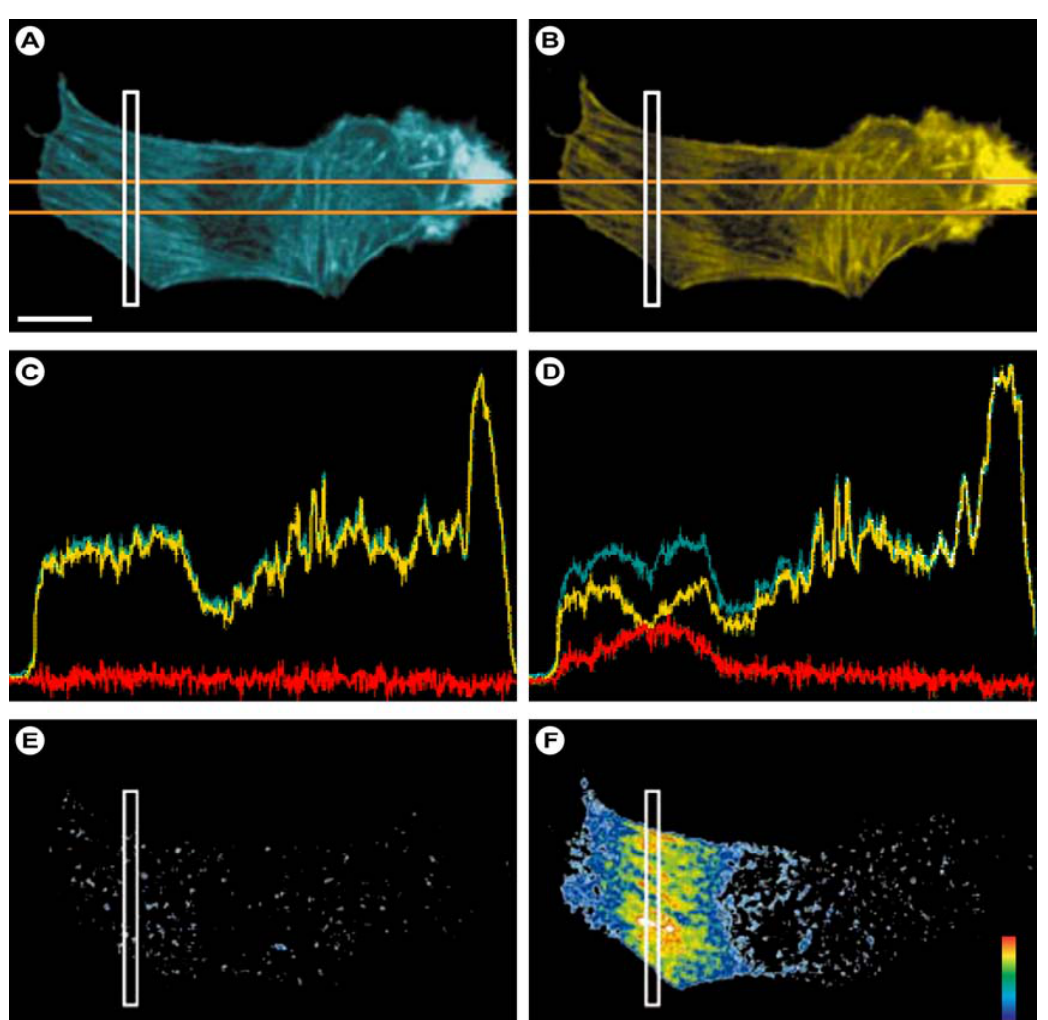
( B ) images immediately after photobleaching the lamella in a narrow strip (white rectangle). Intensity profiles integrated between the orange lines before ( C ) and after ( D ) photobleaching show CFP (cyan), YFP (yellow) and FLAP (red) signals. The FLAP images corresponding to the profiles ( C ) and ( D ) are shown encoded in pseudocolor in (E) and ( F ). Bleach time 3.8 s. Scale bar: 10 µm. Reproduced from [140] with permission. © 2002